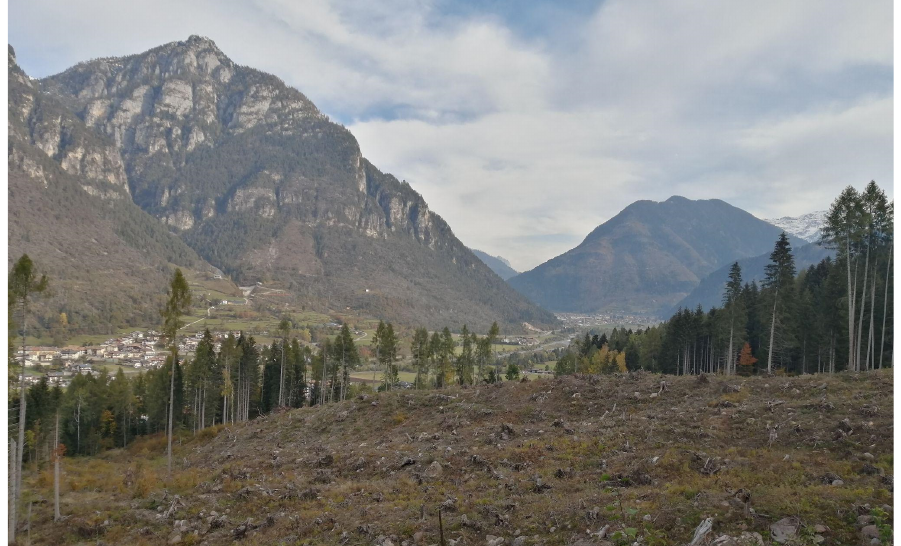
Figure 5. Large clearing near Ziano in the Fiemme Valley (Italy). In the background, a few larches that have survived the windthrow are visible (May 2020) (© authors 2022).